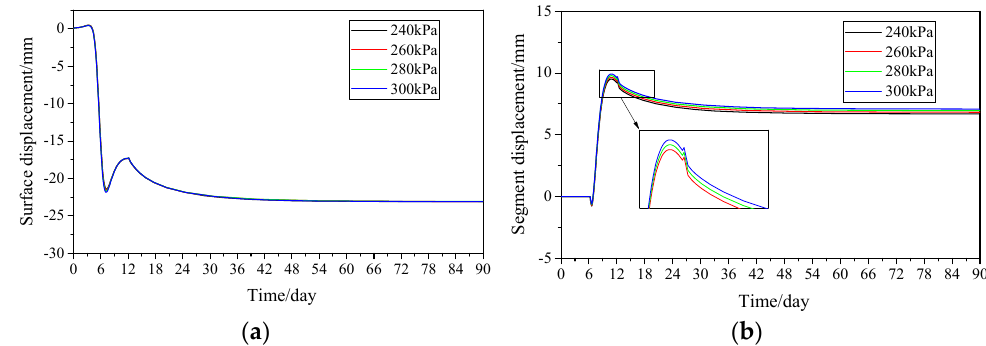
Figure 9. Displacement of surface and tunnel under different grouting pressure. ( a ) Development of surface displacement with time; ( b ) Development of segment displacement with time.